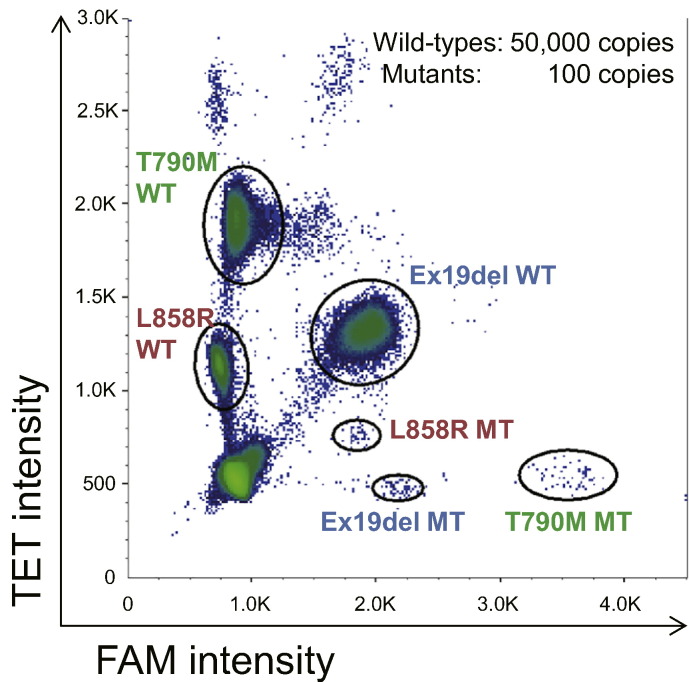
Multiplex assay for analysis of EGFR mutations. Two-dimensional histogram of the 6-hexaplex assay is shown. Plasmids containing each target sequence were encapsulated in droplets and subjected to the ddPCR assay. FAM, 6-carboxyfluorescein; TET, tetrachlorofluorescein.